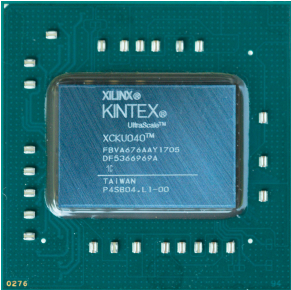
Figure 5: Image of a Xilinx Ultrascale XCKU040-1FBVA676 device in a flip-chip BGA package [AVN18]. The exposed silicon backside of the die can be seen in the middle of the